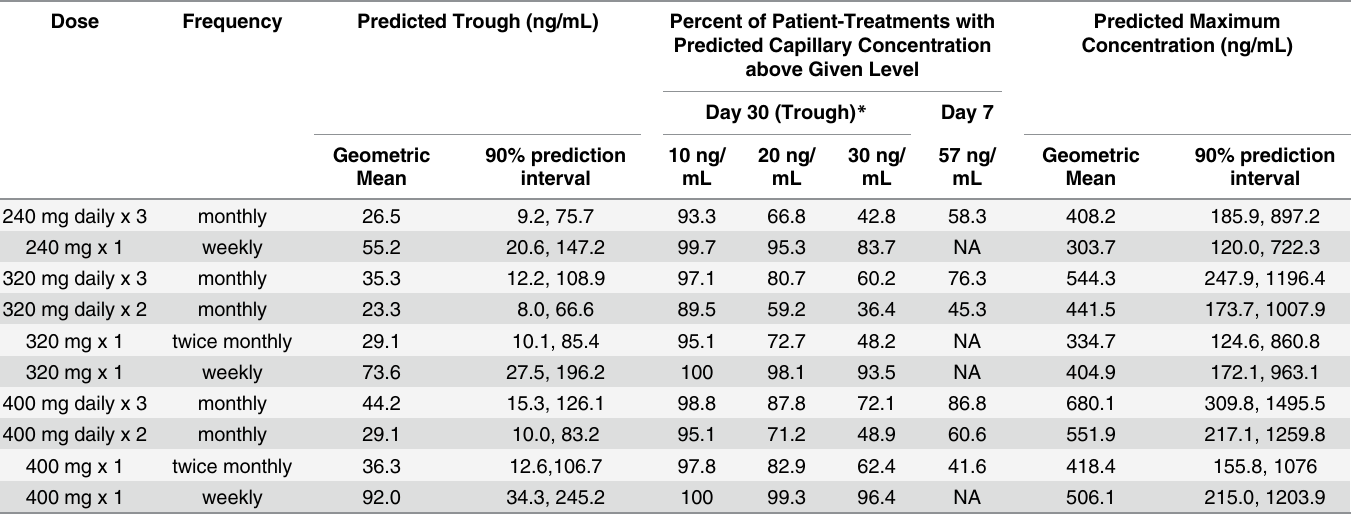
Table 2. Predictions related to trough and peak capillary plasma concentration of PQ at steady-state with various chemoprevention regimens of DP in 1 – 2 year olds weighing (cid:4) 11 kg. Dose Frequency Predicted Trough